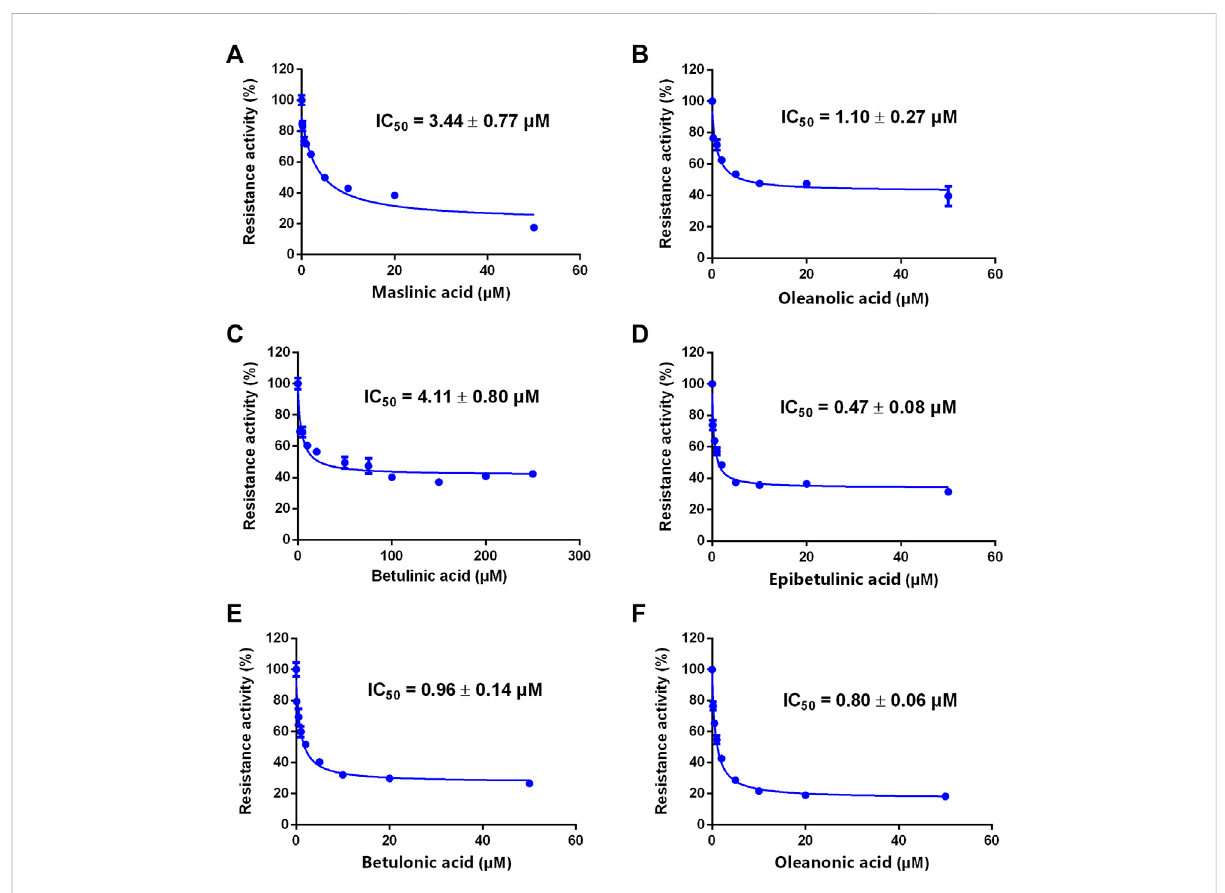
FIGURE 6 Theinhibitoryeffectsofthepentacyclictriterpenoidacids(maslinicacid (A) ,oleanolicacid (B) ,betulinicacid (C) ,epibetulinicacid (D) ,betulonic acid (E) and oleanonic acid (F) ) against NEN-hydroxylation in HLMs. Data are expressed as mean ±